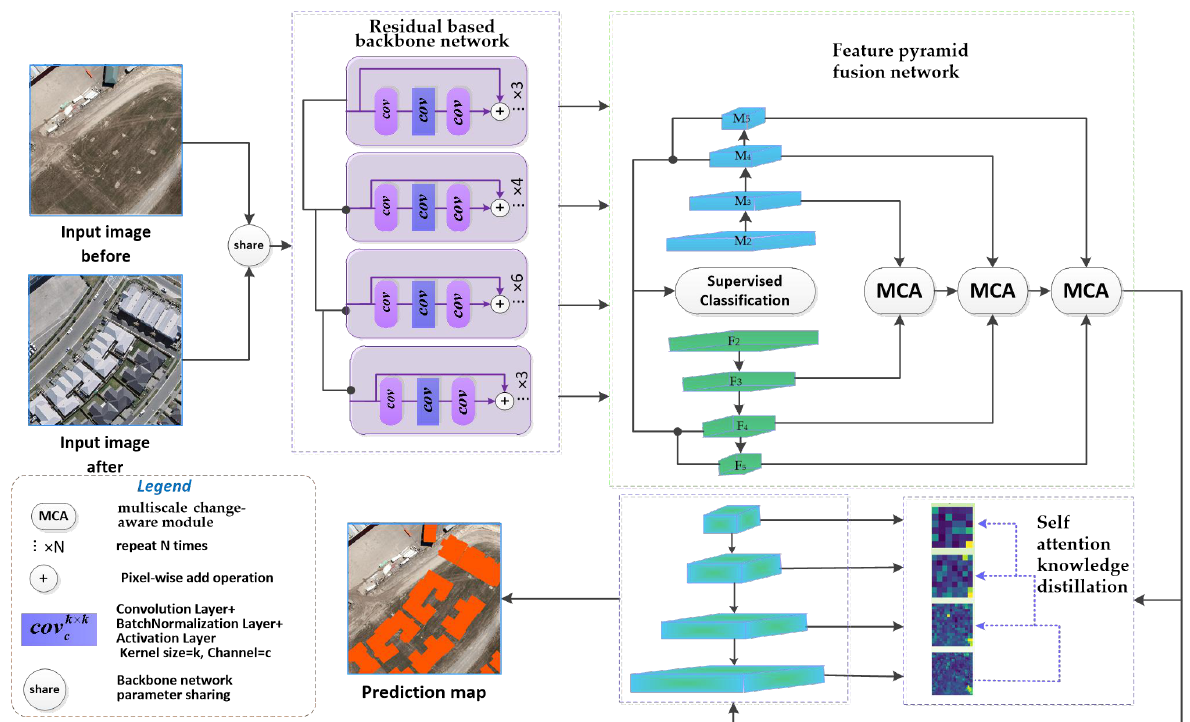
Figure 1 . The proposed network